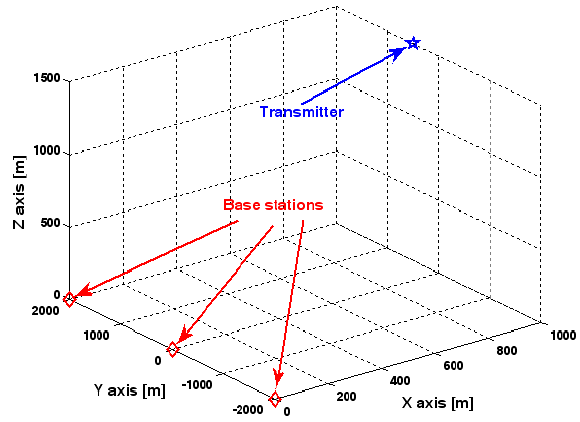
Figure 7. Source location scenario for simulation.